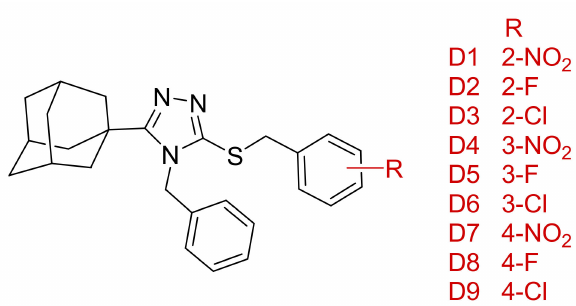
Figure 12. Chemical structure and R- group substitutions of the CADD designed compound